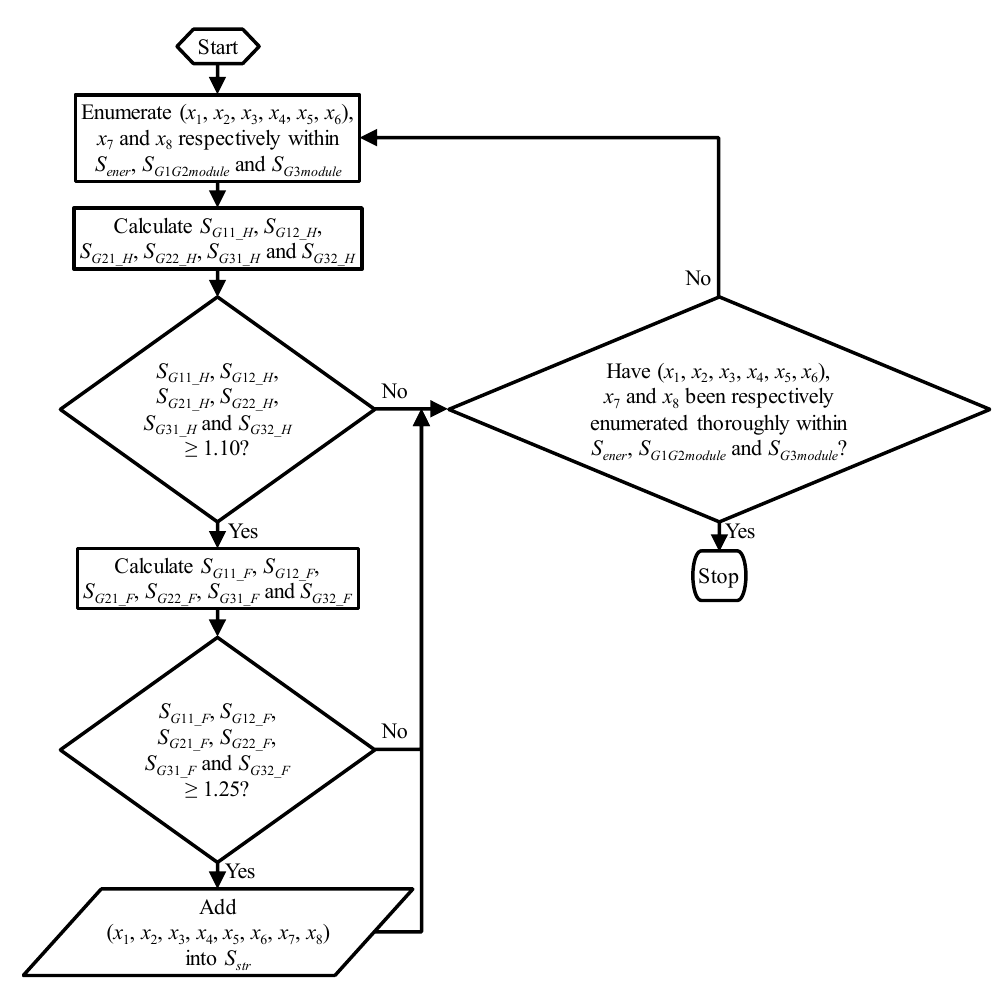
Figure 11. Scheme of the enumeration for the safety factors.